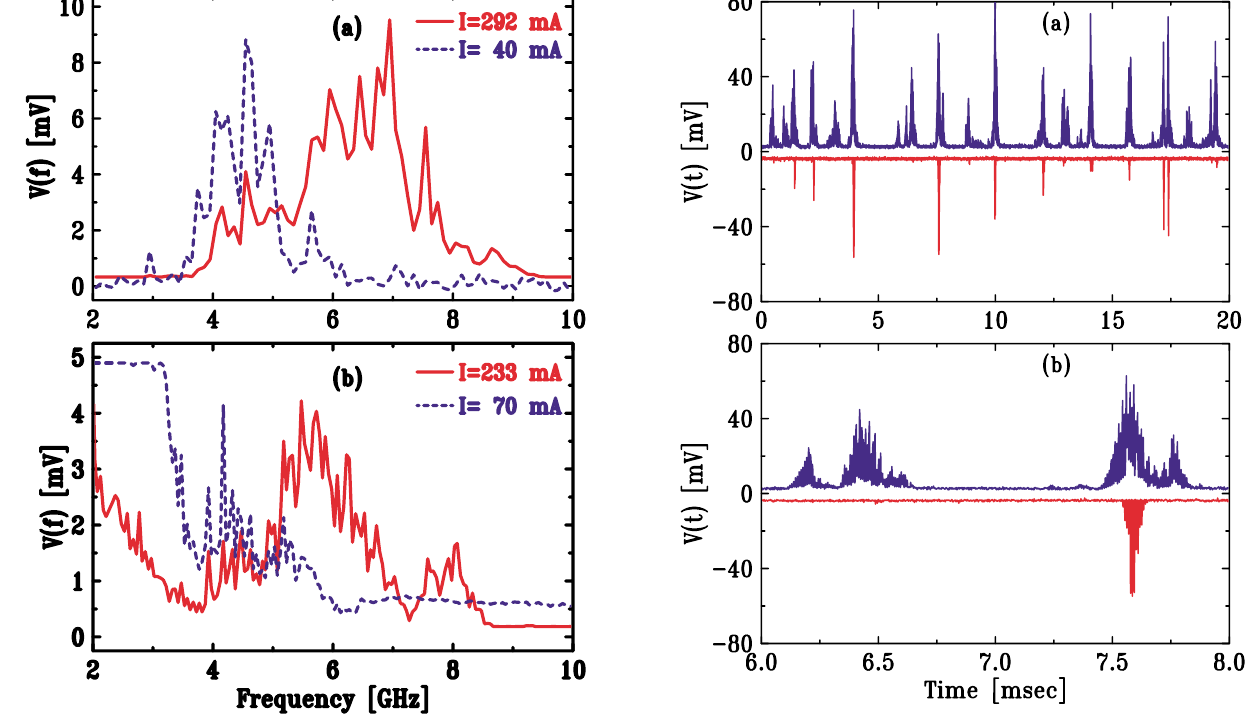
bursts.FIG. 6. (Color) Measured frequency spectrum for two values of bunch current: (a) microwave signal I (cid:6) 292 and 40 mA (scaled by 220 X ) and (b) bunch current signal I (cid:6) 233 and 70 mA (scaled by 15 X